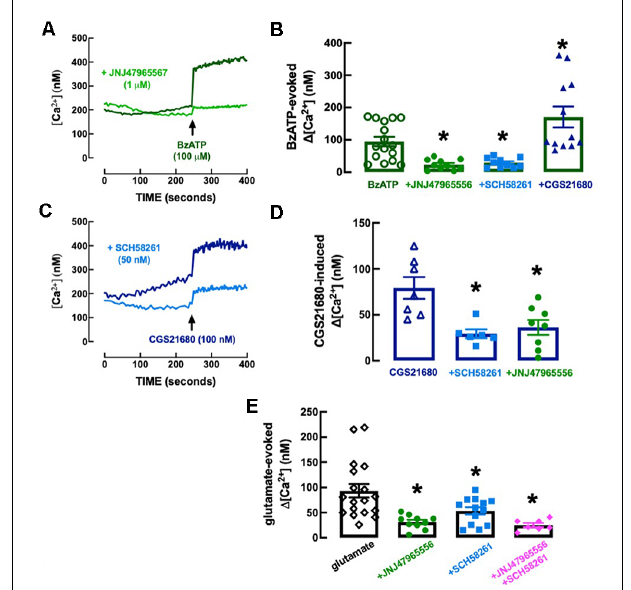
FIGURE 8 | Functional interaction between P 2X7 and A 2A receptors in the control of calcium responses in N9 microglial cell lines. (A) The Fluo-4 fluorescence signal reporting alteration of intracellular free calcium levels ([Ca 2+ ] i ) was increased by the P 2X7 receptor agonist BzATP (100 µ M), an effect abolished by the selective P 2X7 receptor antagonist JNJ47965567 (1 µ M), added 15 min before BzATP. (B) Furthermore, the addition 15 min before BZATP of the A 2A receptor antagonist SCH58261 (50 nM) decreased and the A 2A receptor agonist CGS21680 (100 nM) increased BzATP-induced increase of [Ca 2+ ] i ( ∆ [Ca 2+ ] i ). (C) CGS21680 also increased [Ca 2+ ] i in a manner attenuated by SCH58261, as well as by JNJ47965567 (D) , each added 15 min before CGS21680. (E) Glutamate (100 µ M) also increased [Ca 2+ ] i , an effect attenuated by both JNJ47965567 and by SCH58261, and their simultaneous presence caused an inhibition similar to each antagonist alone (antagonists being added 15 min before glutamate). The time course recordings are from representative experiments, whereas the bar graphs correspond to n = 6–18 independent cultures of N9 microglial cells. * p < 0.05 one-way ANOVA followed by a Dunnett’s post hoc test compared to the first bar from the left (stimulus only, without modifiers, which were added 5 min before the